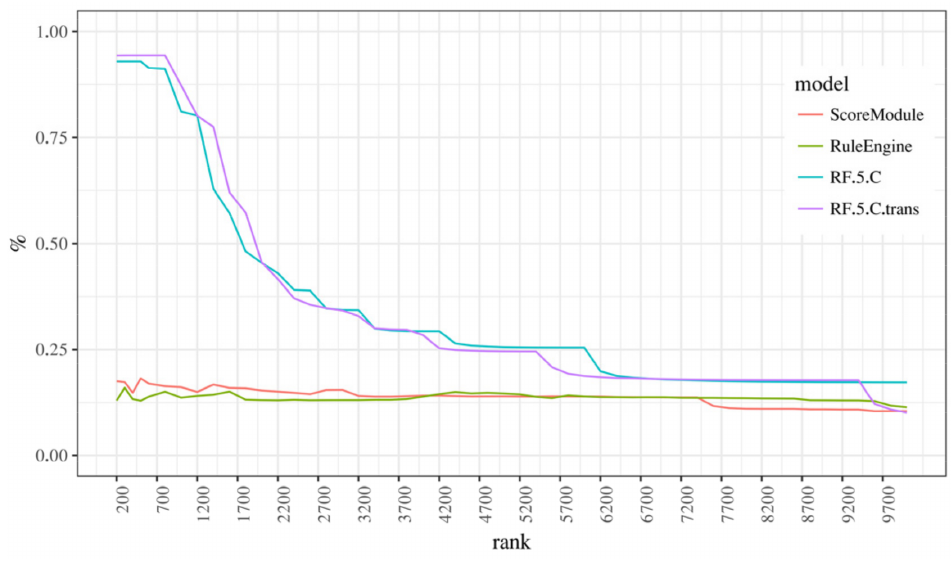
Figure 7. Weighted ranked precision chart for the RF.5.C and baseline models.